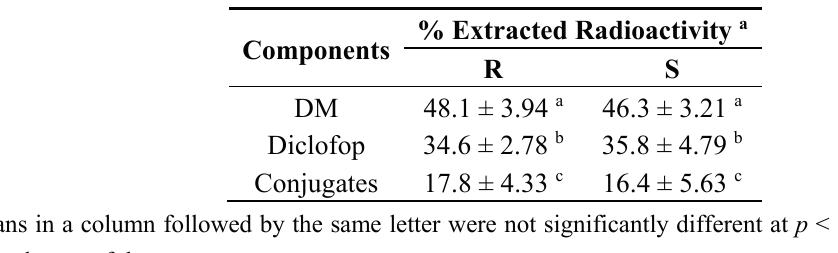
Table 3. DM metabolism in resistant (R) and susceptible (S) biotypes of P. minor 72 h after